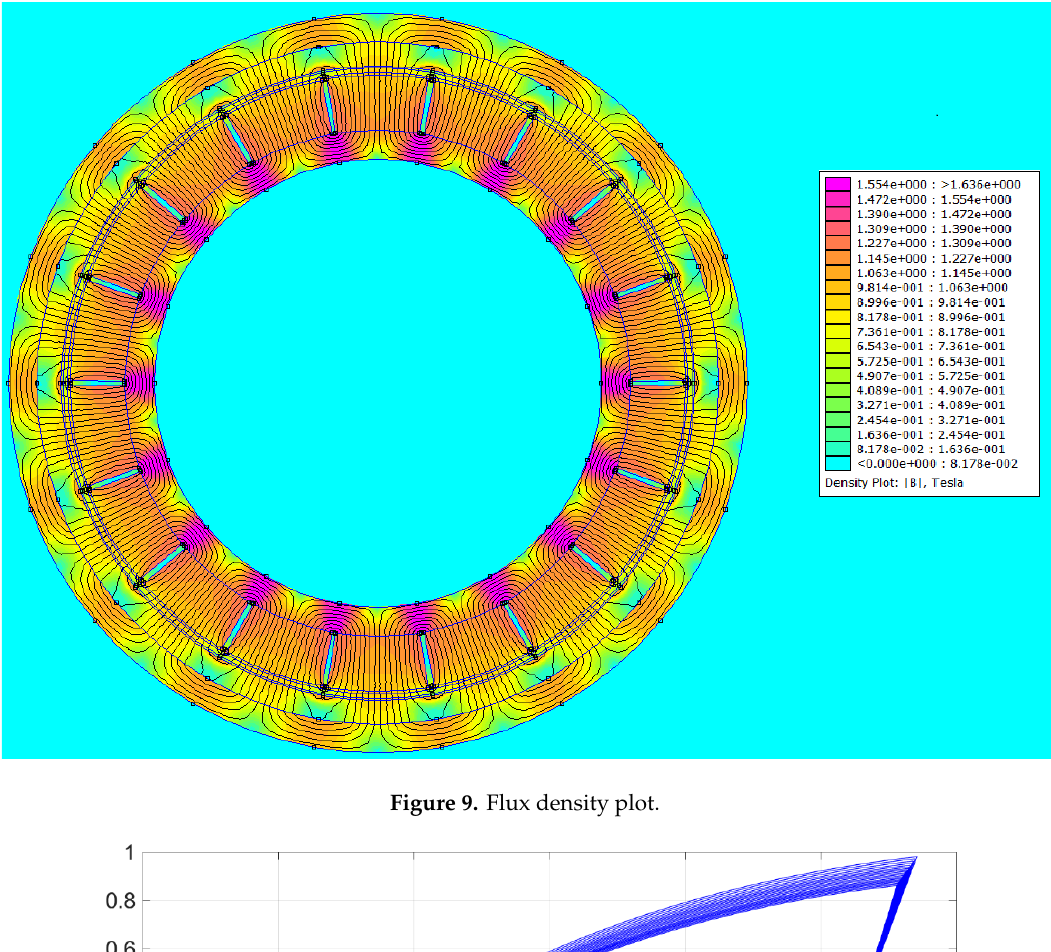
Figure 9. Flux density plot.